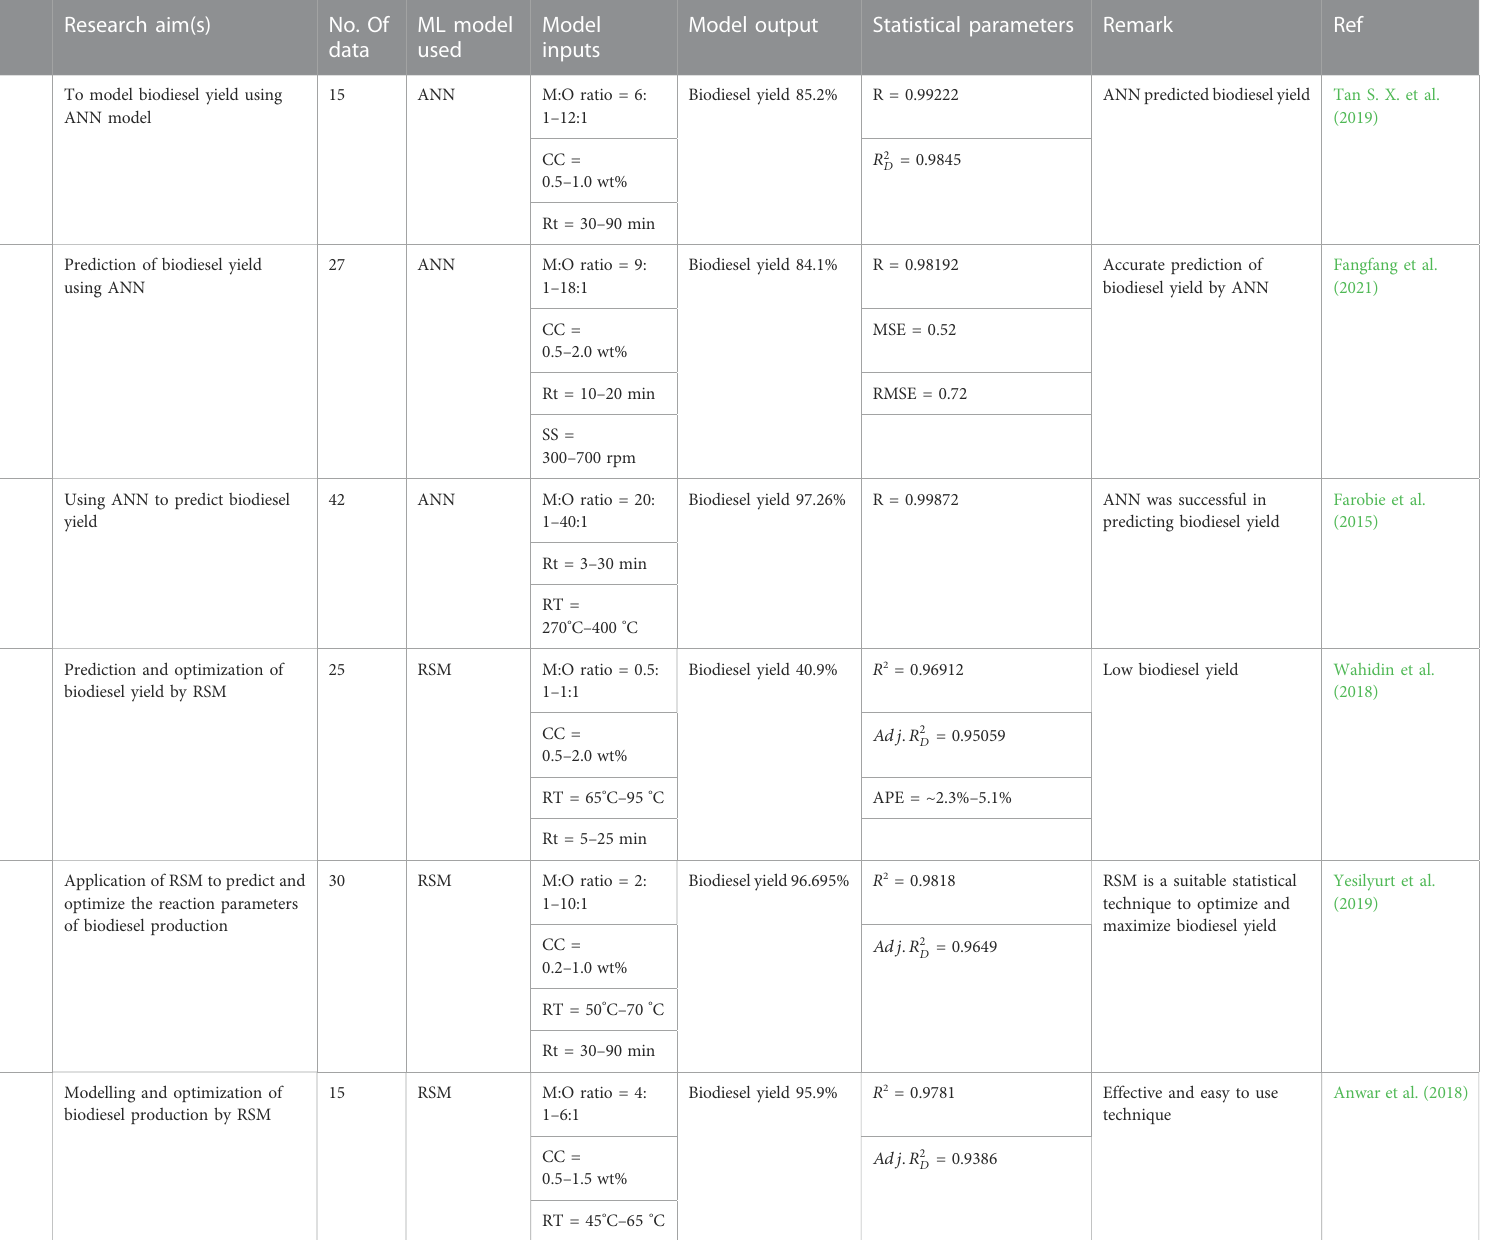
TABLE 6 Application of ML models for modelling, predicting, and optimizing biodiesel process